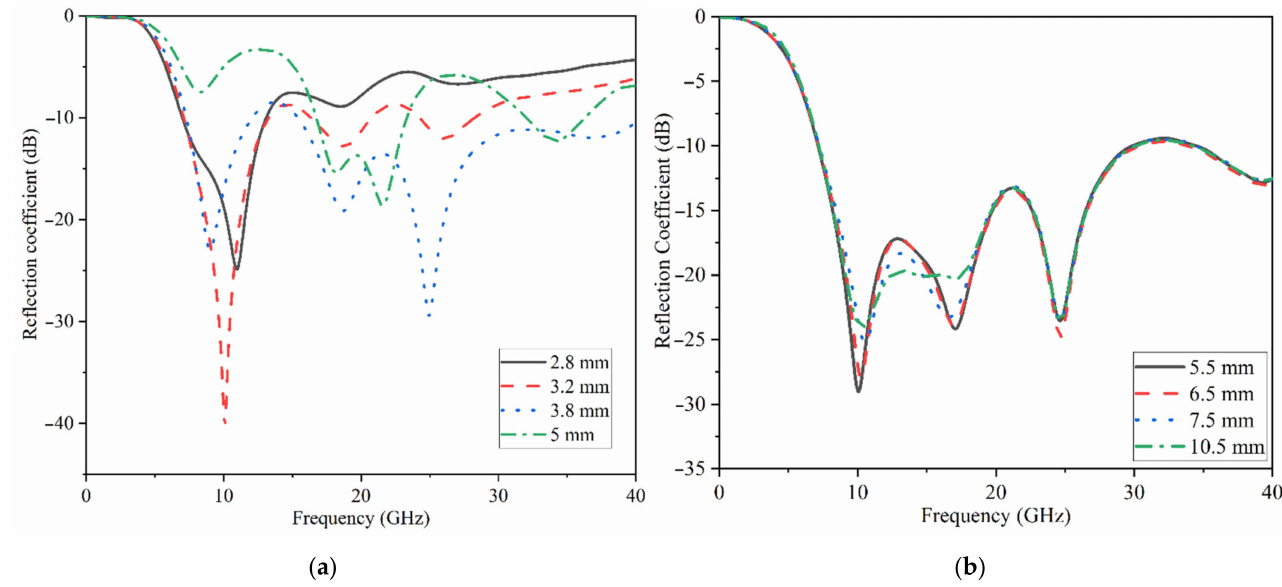
Figure 4. Parametric study of Ant 2: ( a ) ground length, L g and ( b ) the patch’s length, L p .